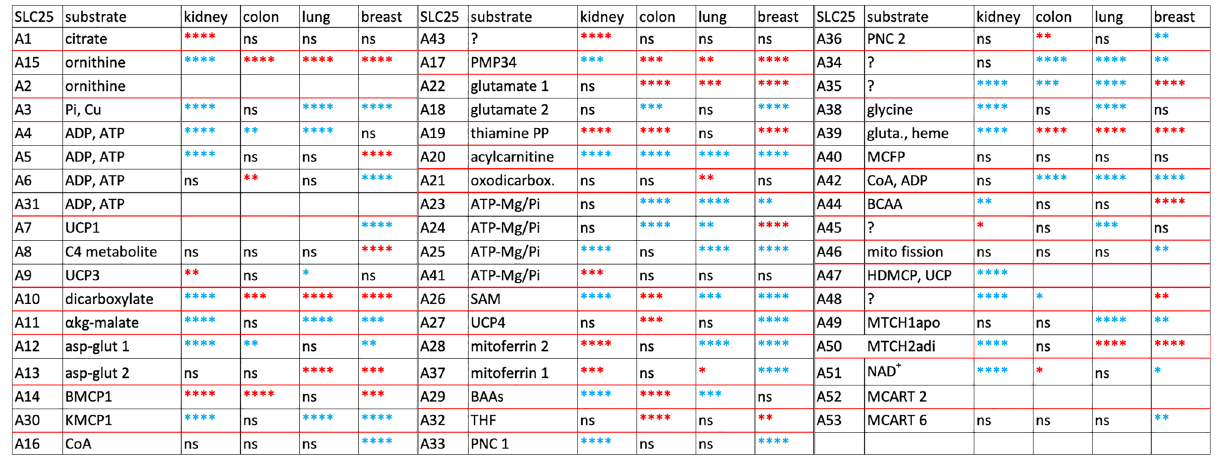
Table 1. Significance of SLC25 transporter genes with induced and suppressed expression in tumors compared to normal tissues Expression (FPKM) ratio of SLC25 gene of cancer per MitoCarta sum of same patient compared to same gene, same ratio for normal tissue of same patient. Transporters grouped between bold red lines have high sequence similarity, i.e., they have at least one transmembrane helix with similarity E-value of less than 1e-04. Substrate column lists transported substrate and/or name of transporter. UCP (uncoupling protein), BMCP1 (brain mitochondrial carrier protein 1), KMCP1 (kidney mitochondrial carrier protein 1), PMP34 (peroxisomal membrane protein 34, the only known SLC25 transporter expressed in peroxisomes and not in mitochondria), SAM ( S -adenosyl methionine), BAA (basic amino acids), THF (tetrahydrofolate), PNC (pyrimidine nucleotide carrier), gluta. (glutathione), MCFP (mitochondrial carrier family protein), BCAA (branched-chain amino acids), HDMCP (hepatocellular carcinoma-down regulated mitochondrial carrier protein), MTCH1apo (apoptosis-related), MTCH2adi (adipocyte-related). p-Values of ratio data of Fig. 2B with red color indicating a ratio > 1.0 and blue color a ratio < 1.0. *(p < .05), **(p < .01), ***(p < .001), ****(p < .0001), ns (not significant). Kidney (KIRC)(n = 61), colon (COAD) (n = 41), lung (LUAD) (n = 54), breast (BRCA) (n =